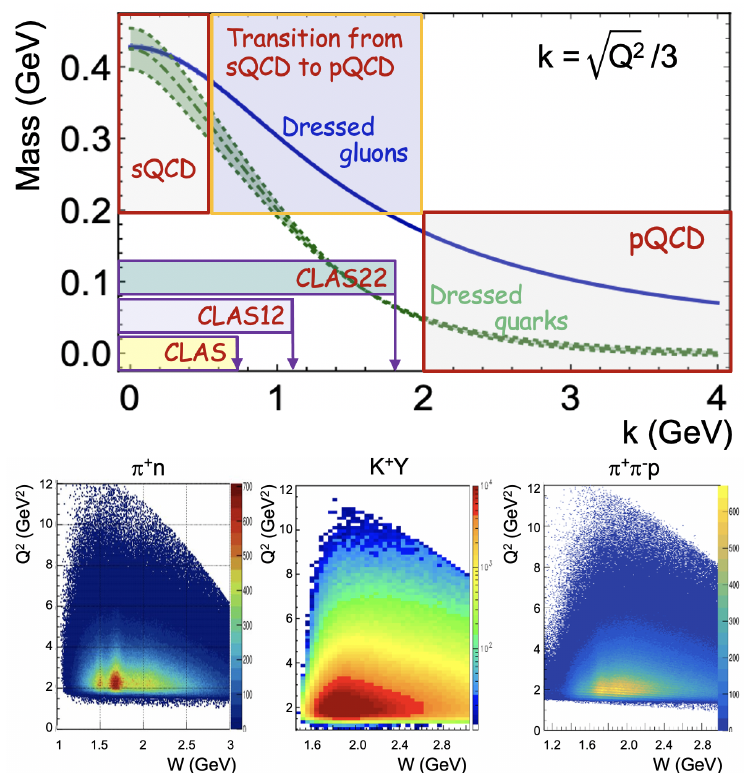
Figure 10. ( Top ) Momentum ranges accessible in the exploration of the momentum dependence of the dressed-quark mass function using results on the Q 2 -evolution of γ v pN ∗ electrocouplings. The range of k covered by available data is mostly from experiments with CLAS, shown in yellow. The expected reach of CLAS12 experiments is shown in purple, and that achievable after a proposed increase of the JLab beam energy to 22 GeV in cyan. ( Bottom ) Yields of representative exclusive meson electroproduction channels available from the experiments with the CLAS12